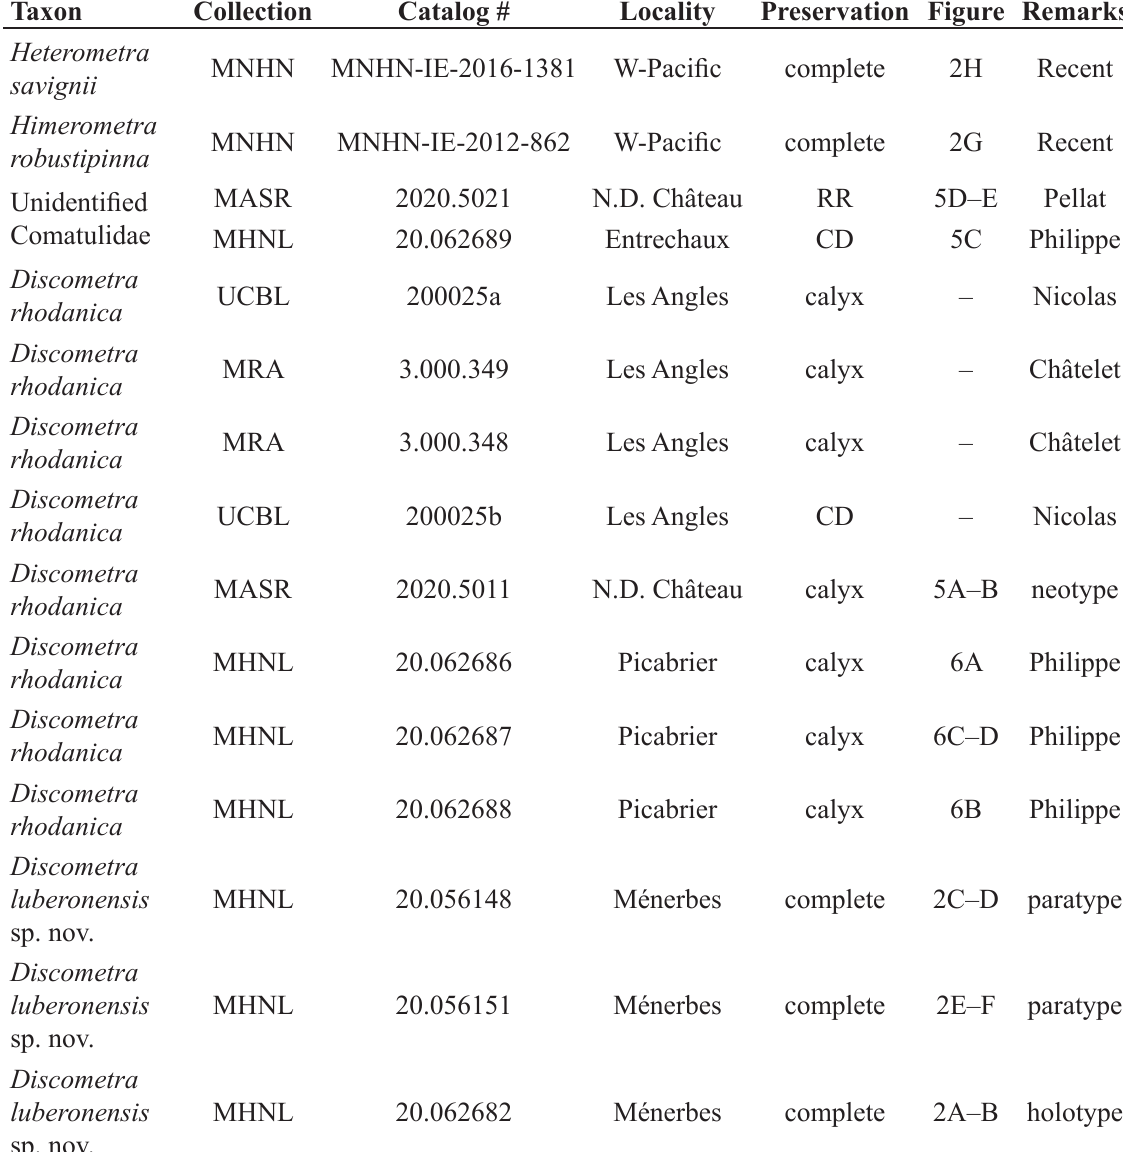
Table 1. List of fossil and extant specimens examined. In the ‘Remarks’ column, the names of the collectors are indicated (except for extant species and type specimens, see text). CD = centrodorsal; RR = radial